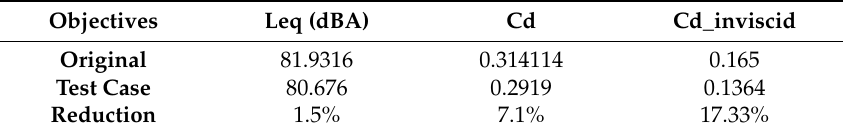
Table 6. The comparison of the objectives before and after optimization.